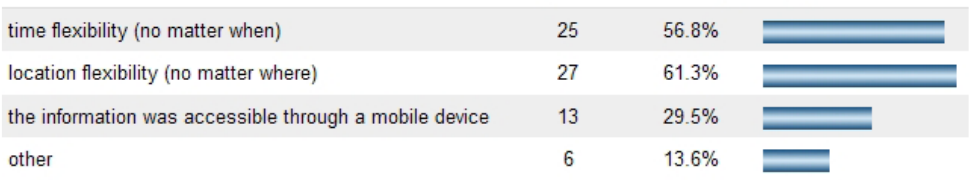
Figure 10 . If so, what was the reason to access the material with a mobile device (please check all that apply)? ( N =